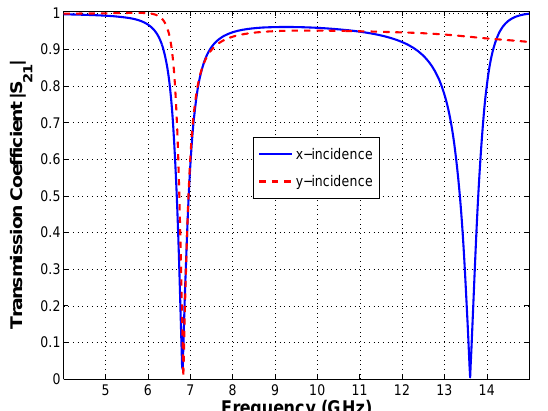
Figure 6: Transmission coefficient for the EC-SRR of Fig. 6, for the x - and y -incidence, respectively. The axes convention is the same as that established in Fig. 1.